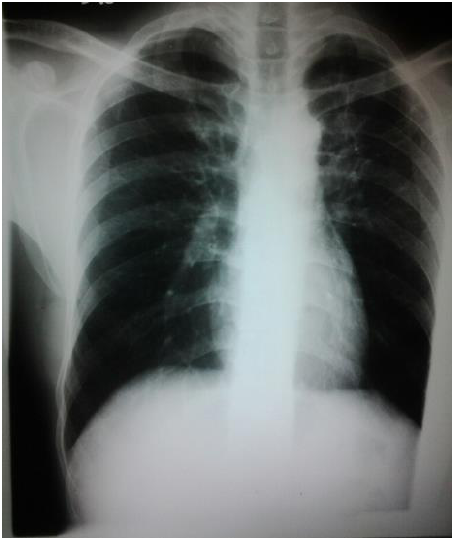
Figure 3. Chest radiography at the end of 3 months of